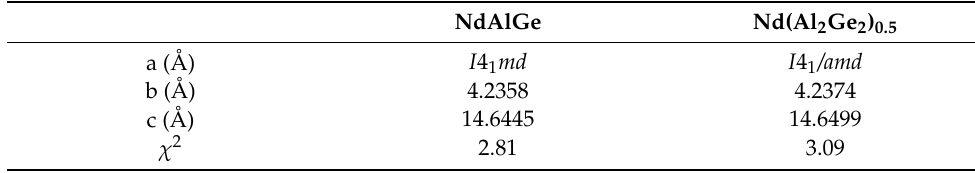
Table 1. Crystal structure of NdAlGe.